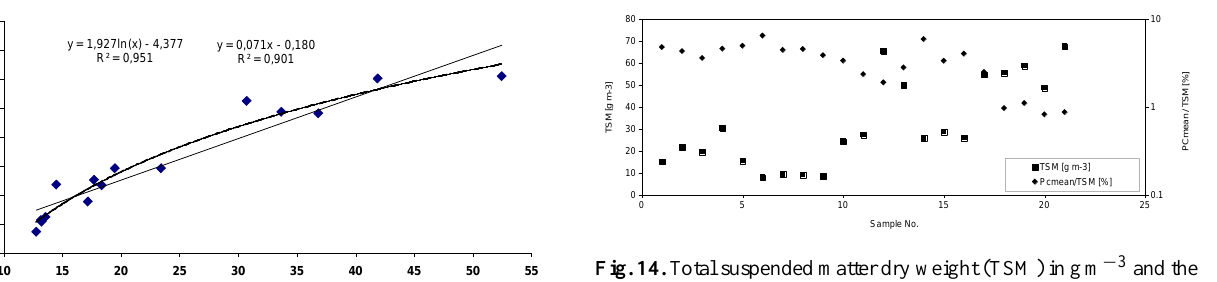
Fig. 14. Total suspended matter dry weight (TSM) in gm − 3 and the Fig. 14 PC content as % of TSM, in sequence of sample number.